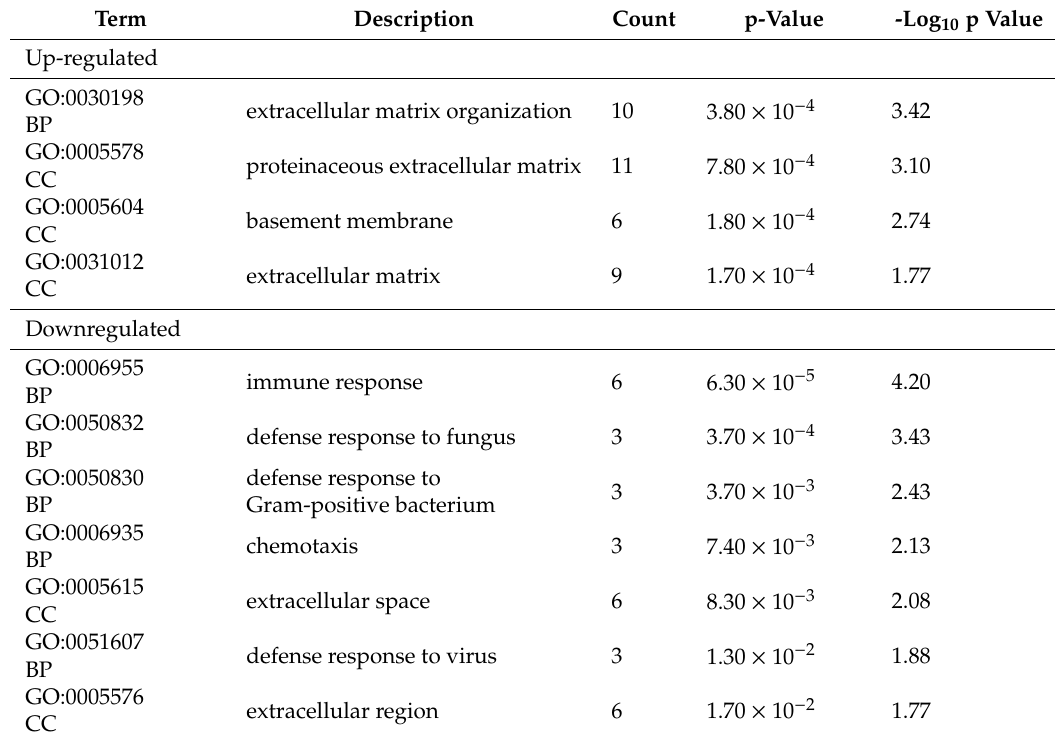
Table 3. The significantly enriched analysis of di ff erentially expressed genes in